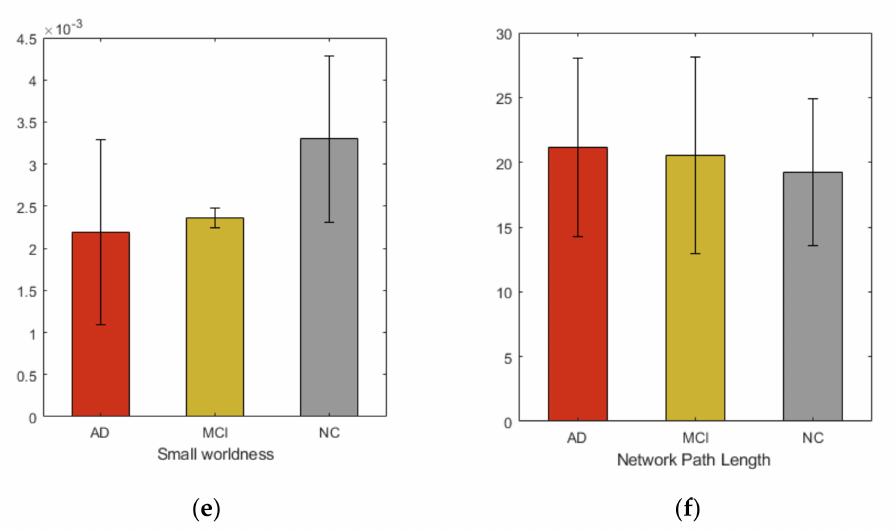
Figure 2. Group averages and comparisons of topological properties ( a ) Density, ( b ) Transitivity, ( c ) Global e ffi ciency, ( d ) Clustering coe ffi cient, ( e ) Small-worldness, ( f ) Network path length.